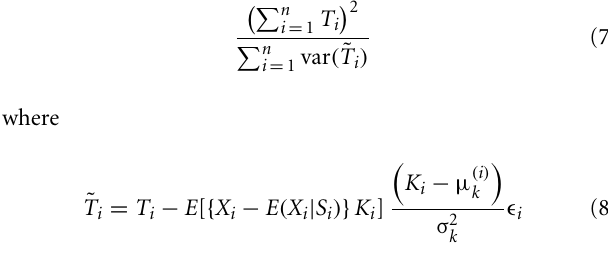
FIGURE 2 | The top left figure represents scenario 1. The top right figure represents scenario 2 which is the same as scenario 1 except that X does not cause L . The bottom left figure represents scenario 3 which is the same